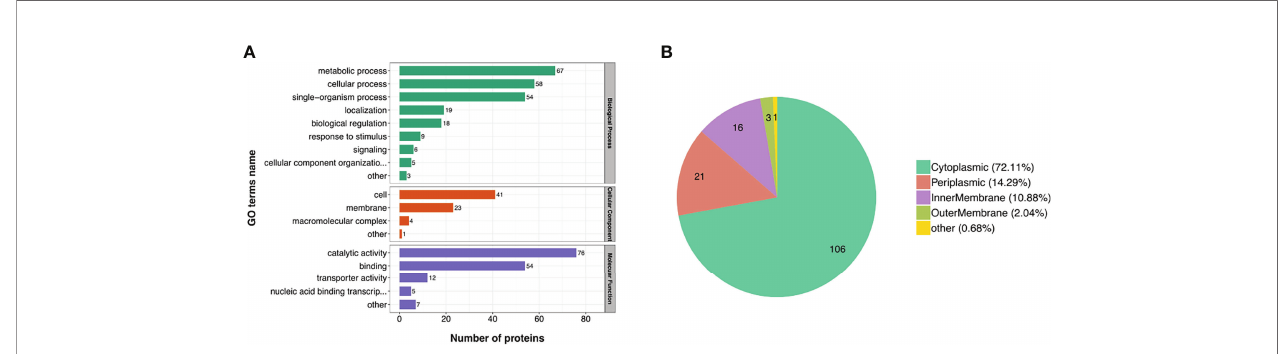
FIGURE 3 | Classi fi cation of GO secondary annotation and subcellular location of DE proteins. (A) The biological function of DE proteins was characterized by biological process, cellular component, and molecular function; (B) The pie chart shows the proportion of subcellular location of DE